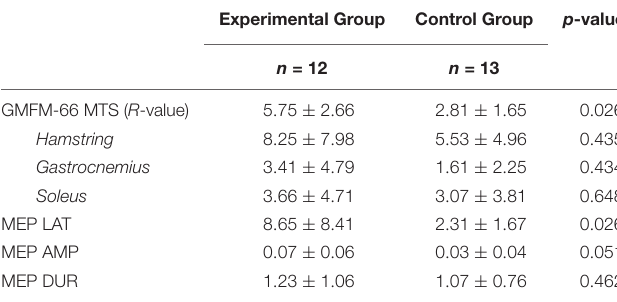
TABLE 3 | Changes of outcome scores (mean ± SD). Experimental Group Control